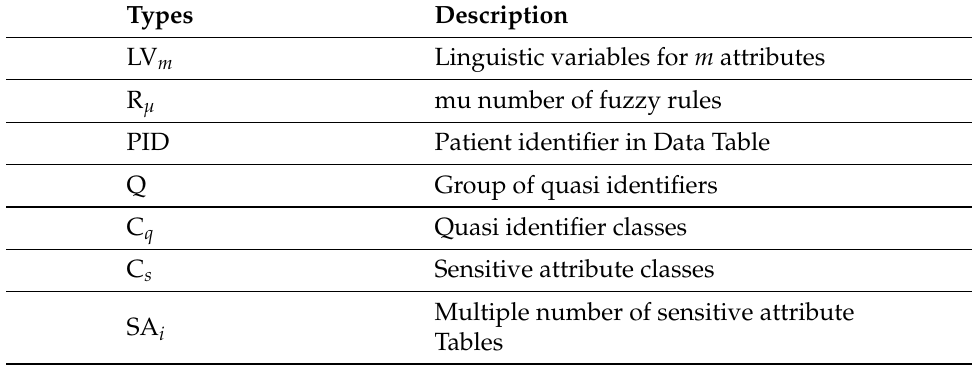
Table 8. Mapping of data types on places.